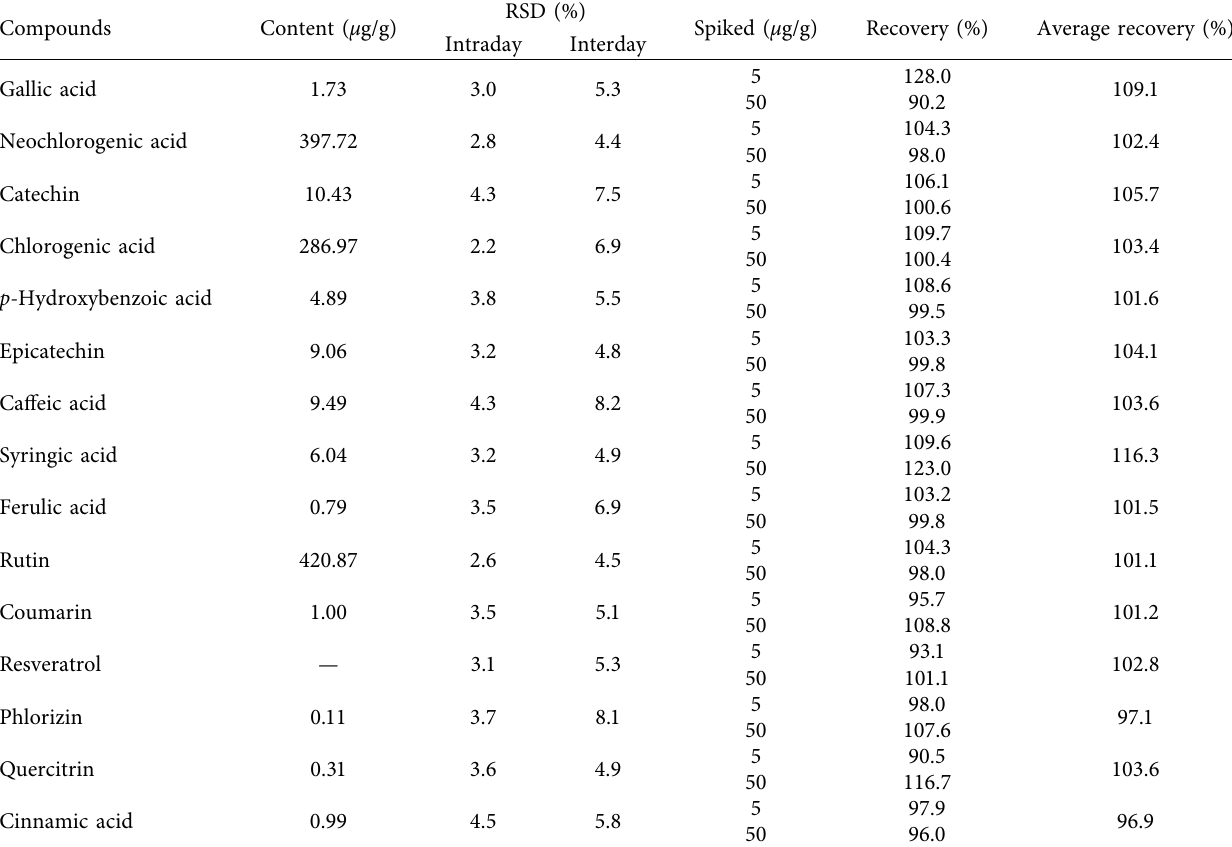
Table 3: Relative recoveries and RSDs of polyphenols from the spiked mulberry juice sample.